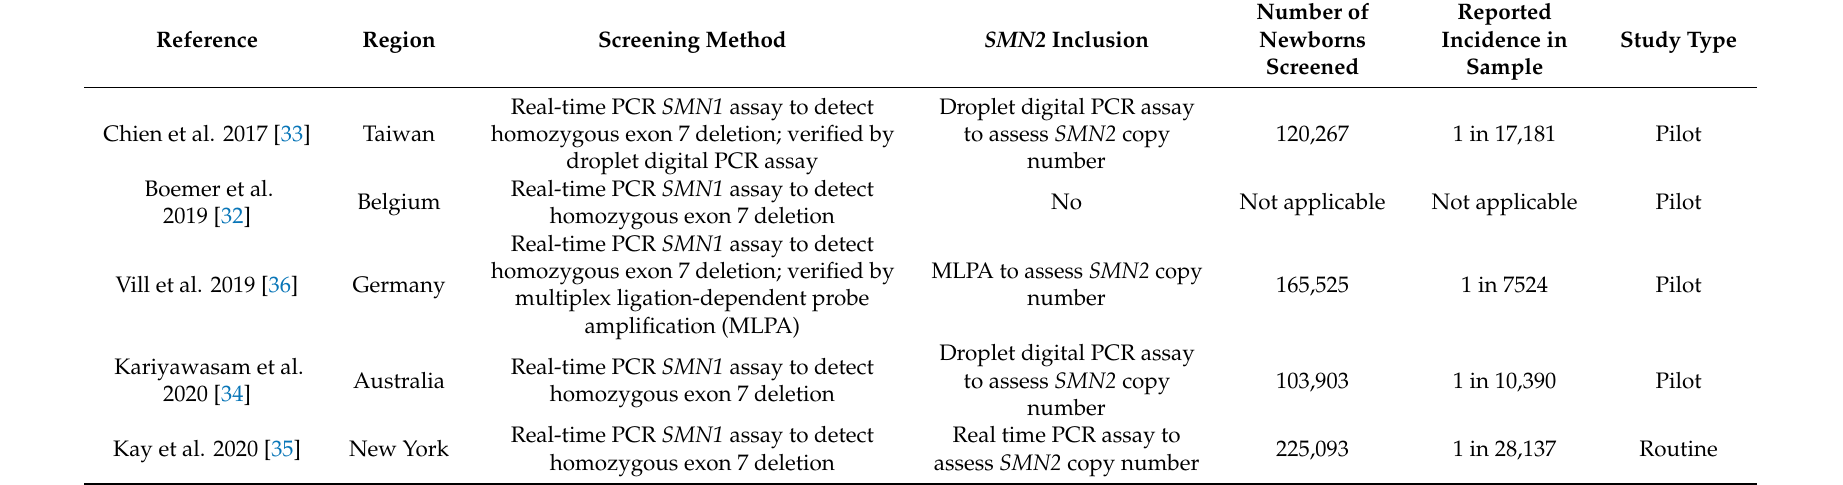
Table 2. Selected spinal muscular atrophy newborn screening